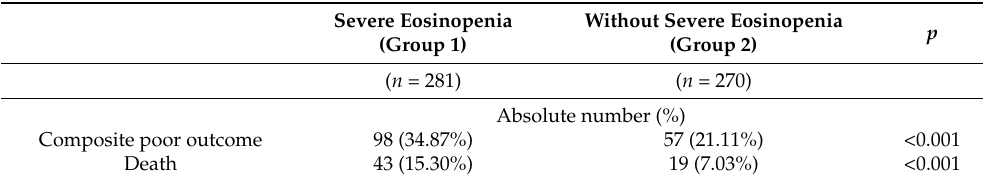
Table 3. Mortality and composite poor outcome including ICU admission and/or oxygen at >6 L/min and/or death in hospitalized COVID-19 patients with and without severe eosinopenia. Severe Eosinopenia Without Severe Eosinopenia (Group 1) (Group 2)